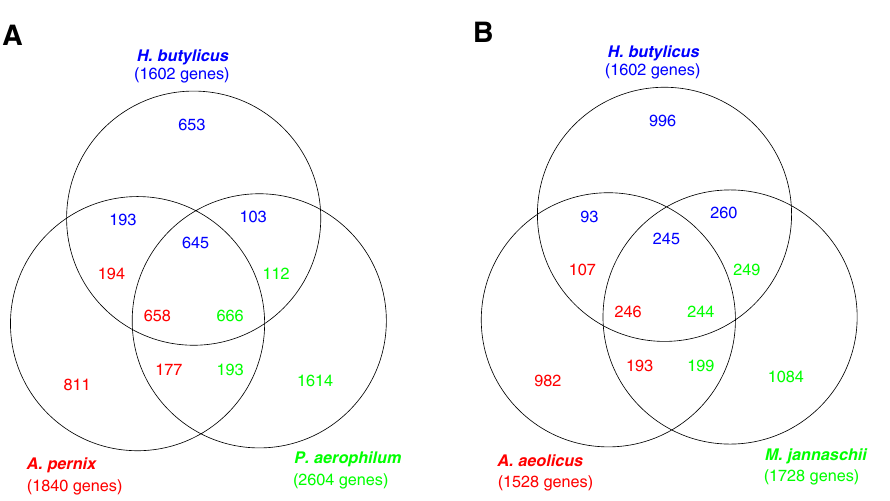
Figure 1. Homologous protein genes of H. butylicus and other hyperthermophiles. The overlap- ping circle plot shows the number of homologs shared between